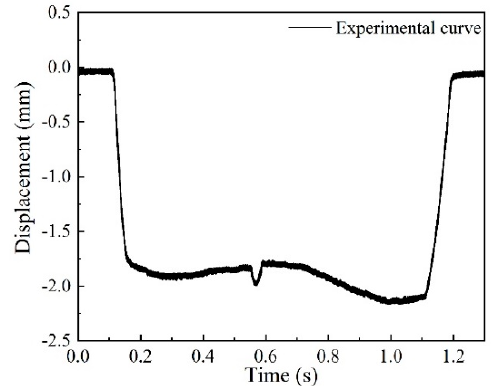
Figure 14. The measuring waveform of a wheel flat.